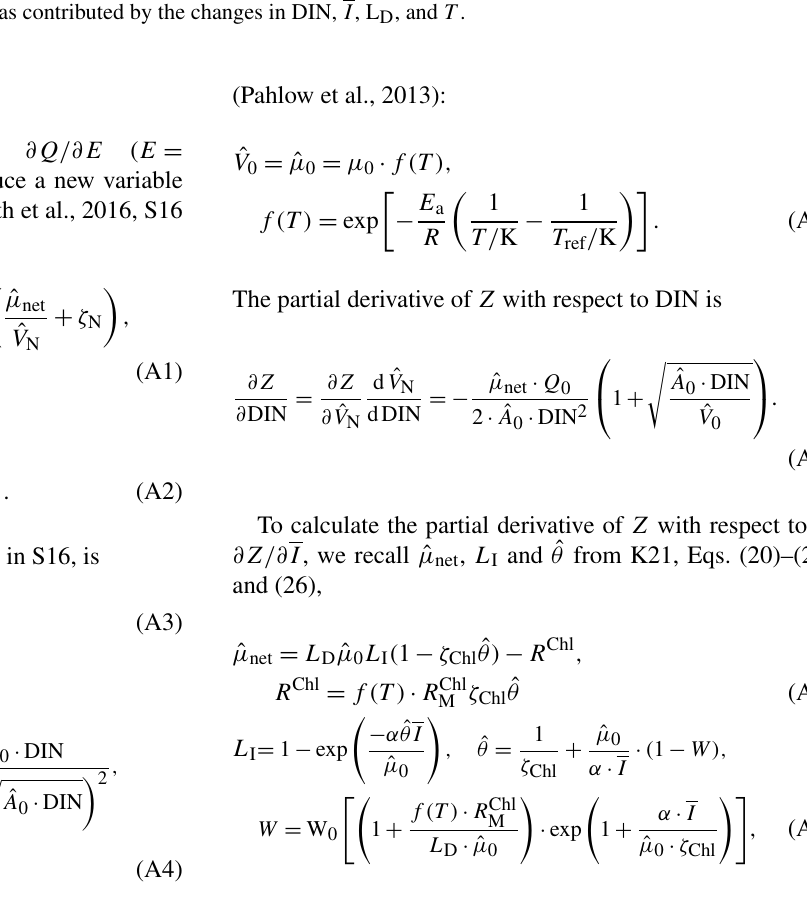
Figure 8. T2: total d Q/ d t and its components as contributed by the changes in DIN, I , L D , and T